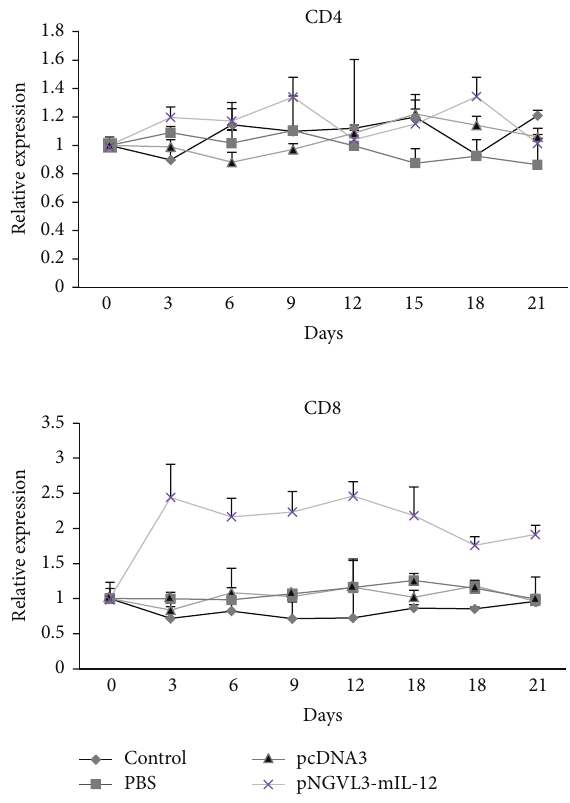
Figure 4: Intratumoral expression levels of CD4 and CD8 mRNA. Tumor-bearing mice were treated with the IL-12 gene expression plasmid (asterisks), pcDNA3 plasmid (triangle), PBS (square), or no treatment as control (diamond). Every three days following treatmentthemiceweresacrificedandbyrealtimeRT-PCRtheCD4 and CD8 mRNA were detected. The CD8 mRNA level expression was higher than the CD4, however, not significant were detected. Results represent the means ± S.E. values of in each 5-mouse group, 𝑃 > 0.01 .